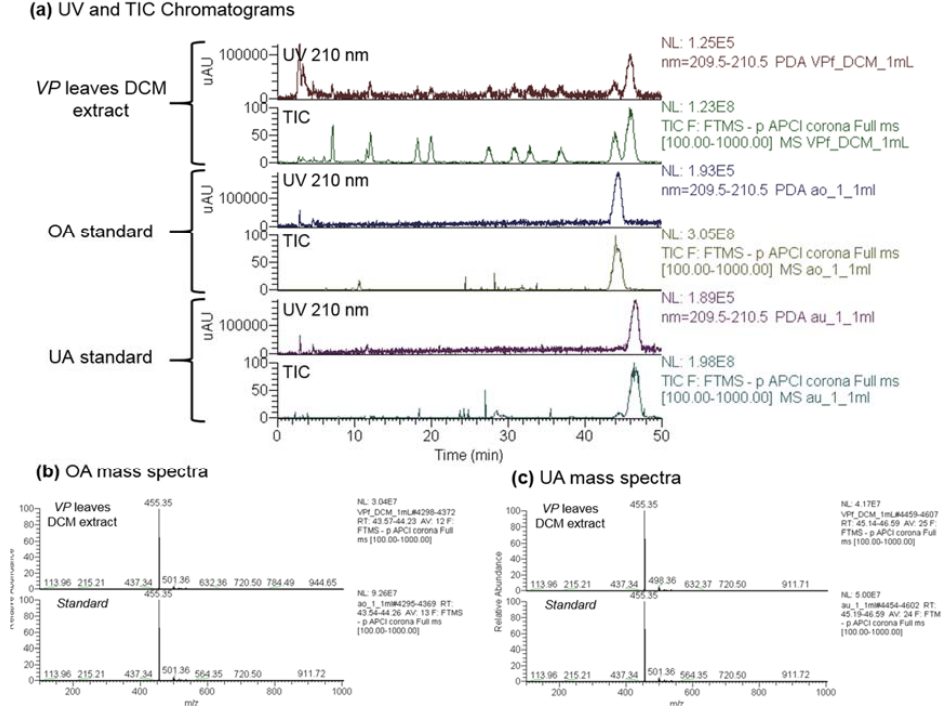
Figure 1. UV (210 nm) and Total Ion Current (TIC) Chromatograms of the Vitellaria paradoxa (VP) leaves dichloromethane (DCM) extract and of ursolic (UA) and oleanolic (OA) acids standards ( a ). Mass spectra of standards and of the peaks at the same retention times in the chromatogram of VP leaves DCM extract than OA ( b ) and UA ( c ).